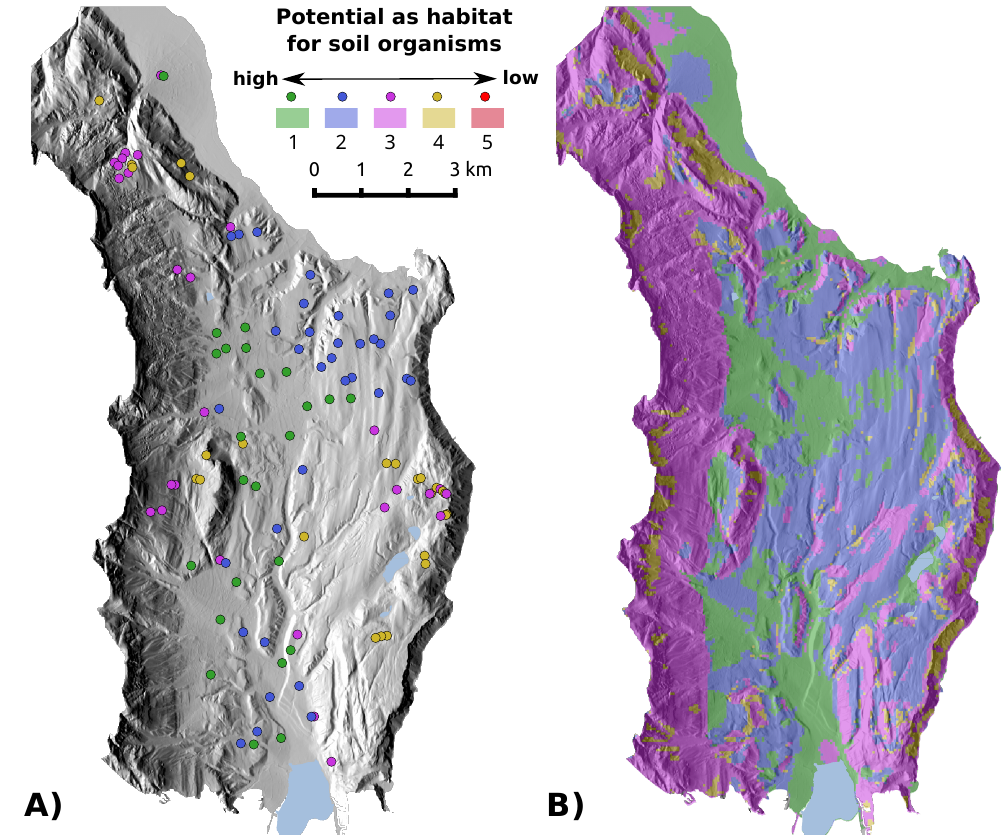
Figure 6. ( A ) shows the study area along with the location of the soil profile sites and their level of soil function fulfillment regarding their function as a habitat for soil organisms as assessed by the SEPP tool. ( B ) shows the fullfillment levels as predicted by a SVM classifier based on the terrain parameters slope, convexity, and cross-sectional